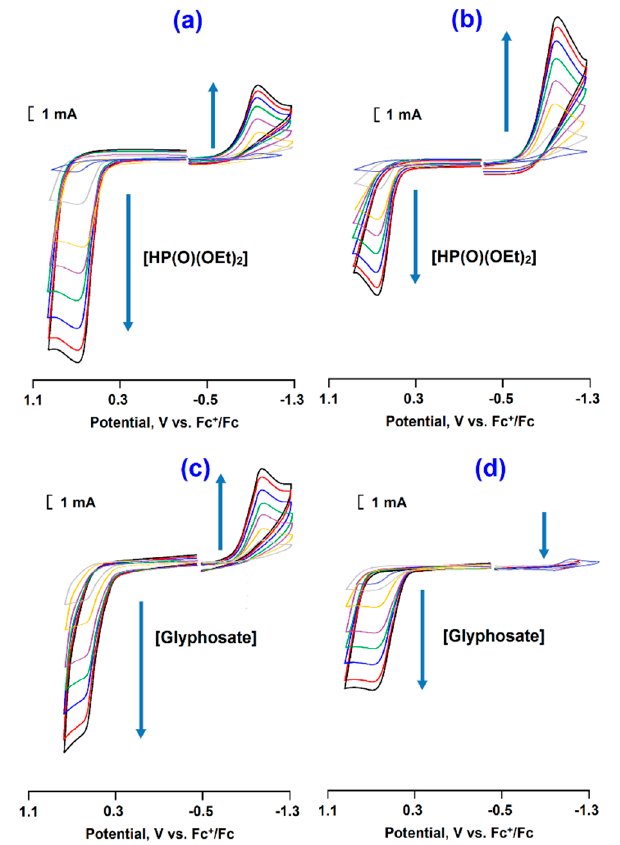
Figure 8. CVs for w / o Co II @SiO 2 ( a , c ) and Stöber Co II @SiO 2 ( b , d ) in the absence and in the presence of Figure 8. CVs for w/o Co II @SiO 2 ( a,c ) and Stöber Co II @SiO 2 ( b,d ) in the absence and in the presence of increasing quantities of HP(O)(OEt) 2 ( a , b ) and Glyphosate ( c , d ) (1.0, 2.5, 5.0, 10.0, 25.0, 50.0 mmol · L − 1 ). increasing quantities of HP(O)(OEt) 2 ( a,b ) and Glyphosate ( c,d ) (1.0, 2.5, 5.0, 10.0, 25.0, 50.0 mmol·L − 1 ). WE: CPE, H 2 O, 10 − 1 mol · L − 1 Et 4 NBF 4 Potentials vs. Ag / AgCl recalculated to Fc + / Fc. Arrows indicate WE: CPE, H 2 O, 10 − 1 mol·L − 1 Et 4 NBF 4 Potentials vs. Ag/AgCl recalculated to Fc + /Fc. Arrows indicate the direction of current the direction of current changes.